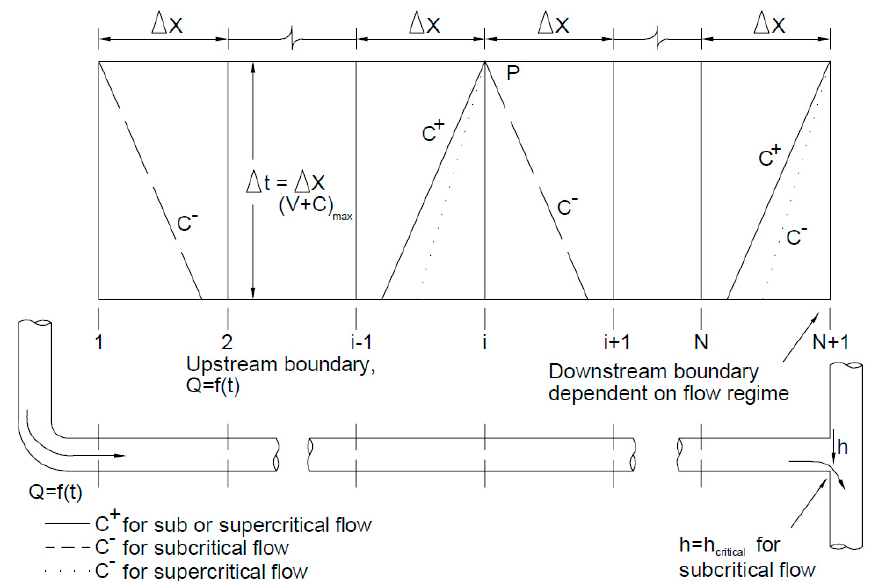
Figure 3. Application of the method of a characteristics-specified time interval grid for a partially filled pipe flow with known entry and exit boundary equations.